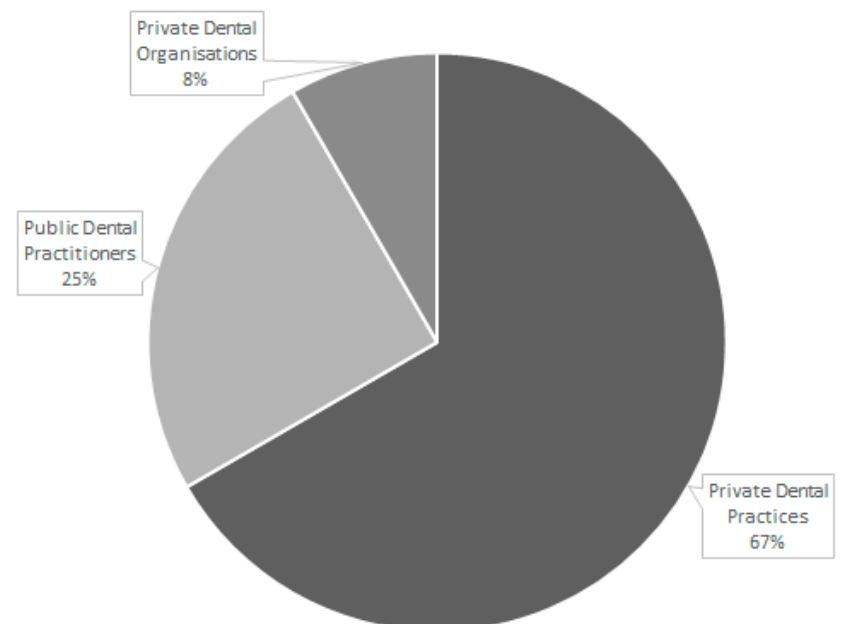
Figure 3. Dental provider demographics.